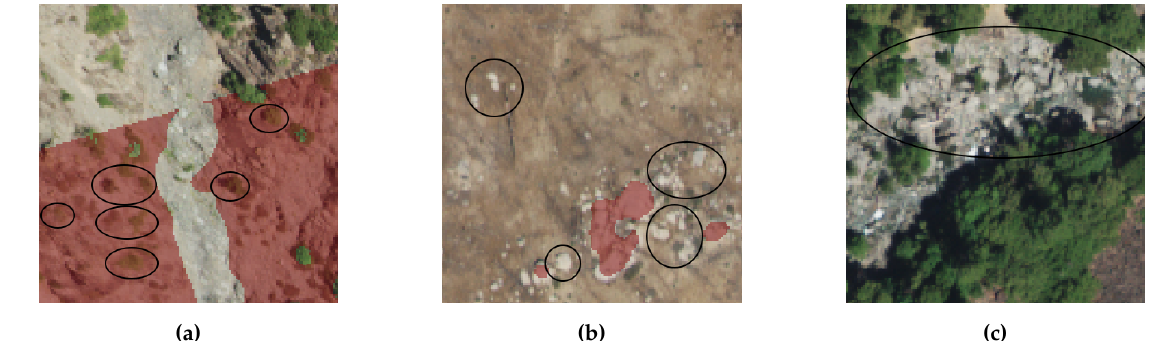
Figure 4. Illustration of false classifications on initial training data. In each scene, the red areas were initially labeled as rock . ( a ) Circled areas are false positives where trees were labeled as rock ; ( b ) The circled areas show false negatives where high-albedo rock was labeled as other ; ( c ) The circled area is ambiguous and may be bedrock or boulders in a stream.